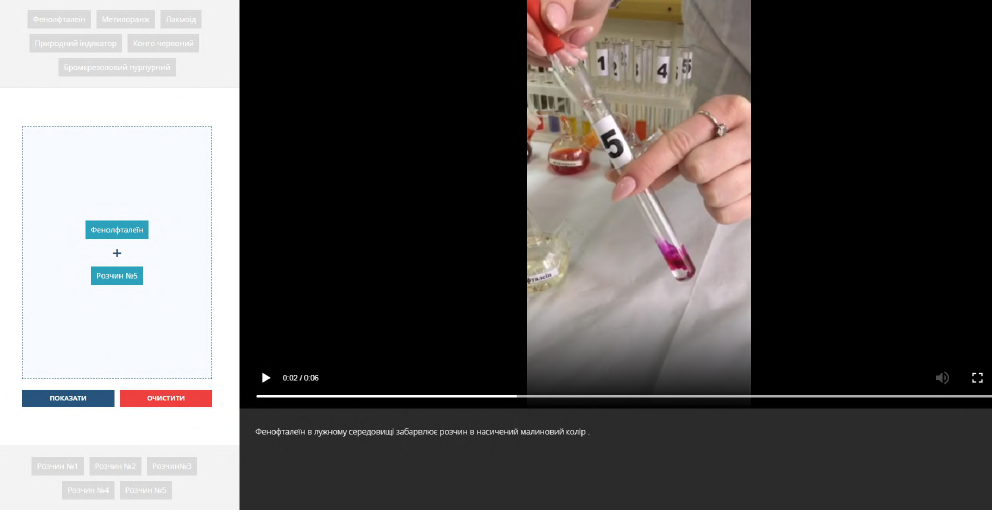
Figure 97: Presentation of paper